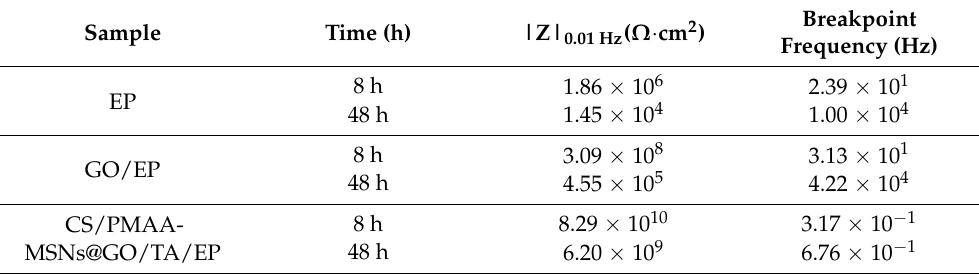
Table 2. The impedance values at 0.01 Hz, and breakpoint frequencies of EP, GO/EP, and CS/PMAA-